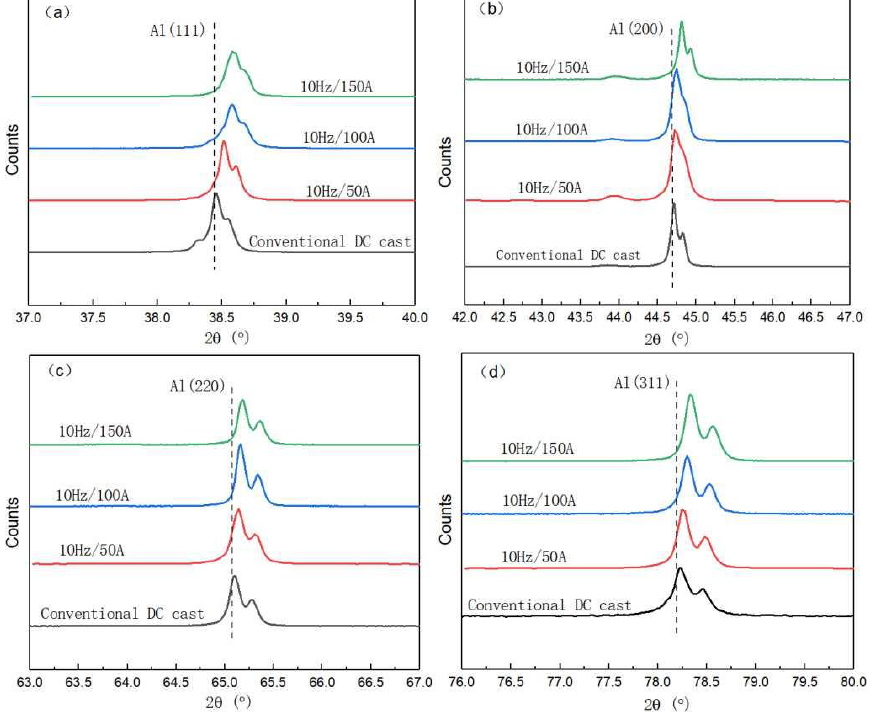
Table 3. Lattice parameters of α(Al) of 2A97 alloy DC casting at different electromagnetic field conditions. Miller indices